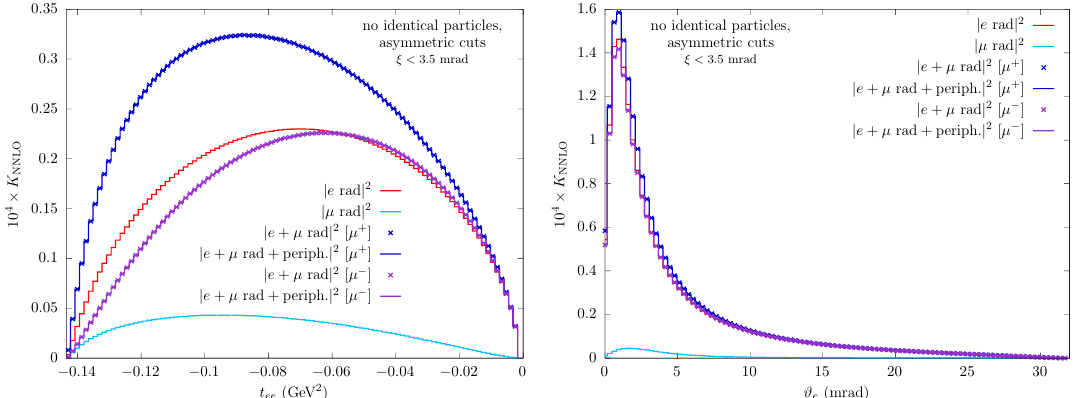
Figure 17. Real e + e − radiation effects with academic event selection on t ee (left) and θ e (right) distribution, in the presence of the acoplanarity